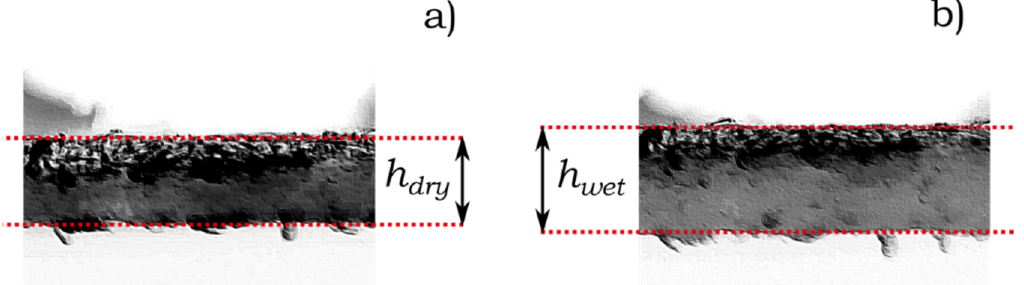
Figure 2. Microscope cross section image of a piece of chromatography paper experiencing hygroexpansive strain along its thickness. Comparison of ( a ) dry thickness (hdry) and ( b ) wet thickness (hwet).